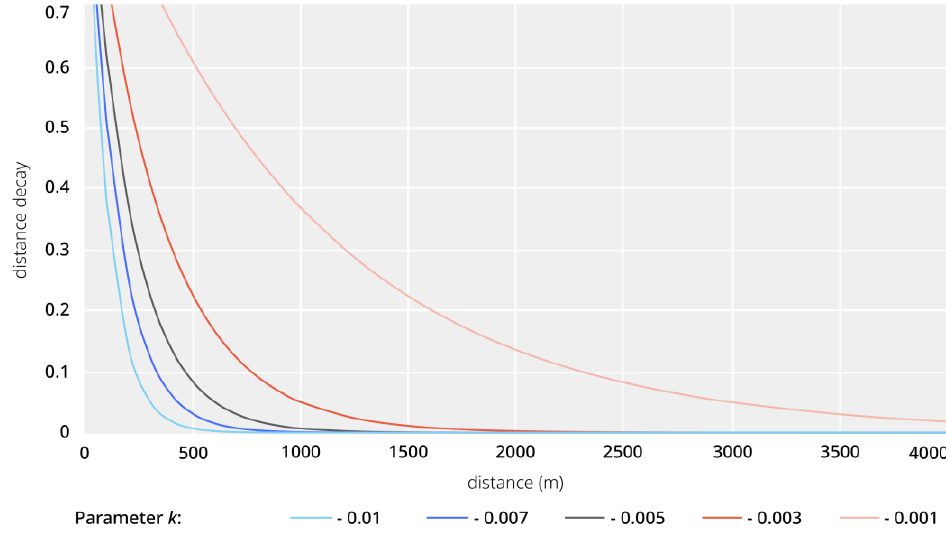
Figure 3. Plots of different exponential decay functions and their effect on distances in meters.